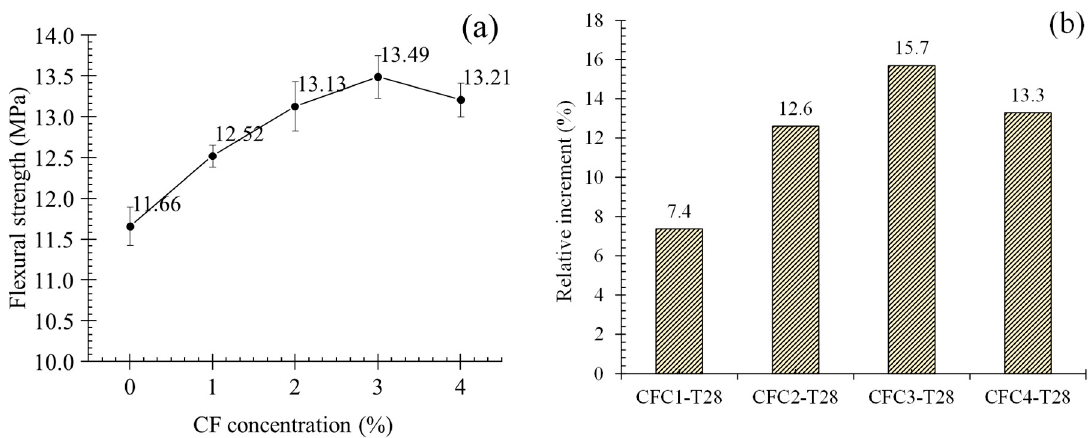
Figure 9. Average flexural strength and its relative increment at 28 days. ( a ) Average flexural strength; ( b ) relative increment.